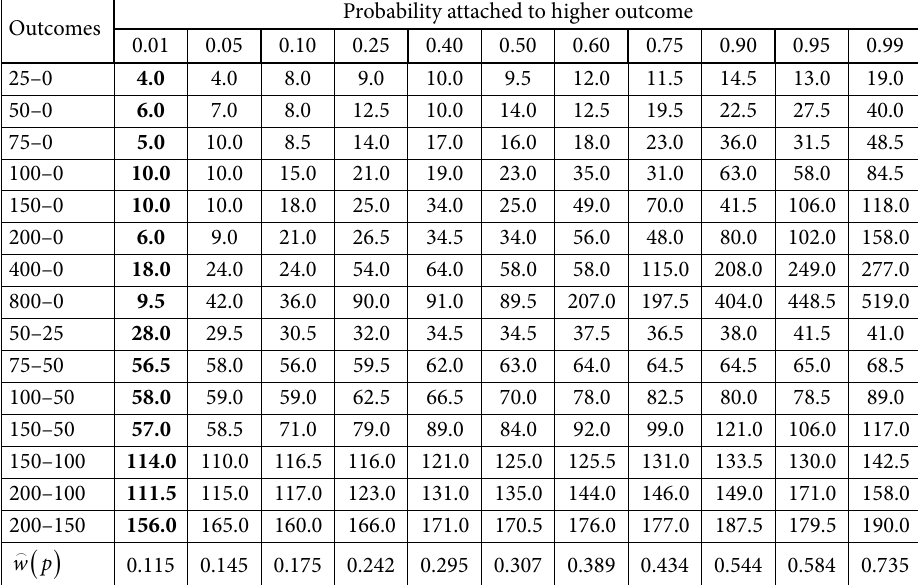
Table 4. Median certainty equivalent for each monetary outcome from Gonzalez and Wu (1999) Probability attached to higher Outcomes